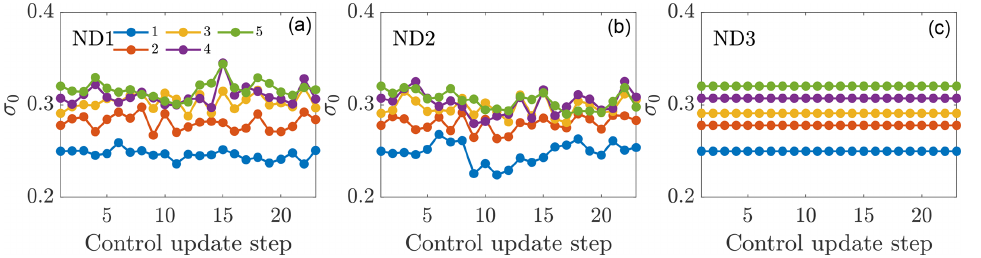
Figure 13. Proportionality constant for the presumed Gaussian wake for each turbine in the wind farm for (a) online control using the initial parameters to initialize the next state (ND1), (b) online control using the previous optimal parameters to initialize the next state (ND2), and (c) the static state estimation control